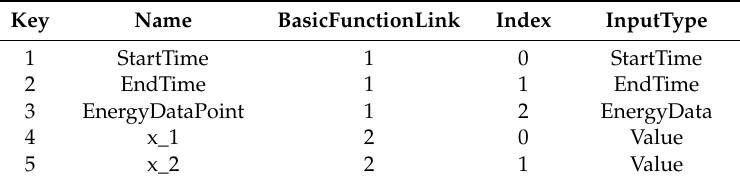
Table 2. Specification in the “BasicFunction” table. Table 3. Specification in the “BasicFunctionInput” table.